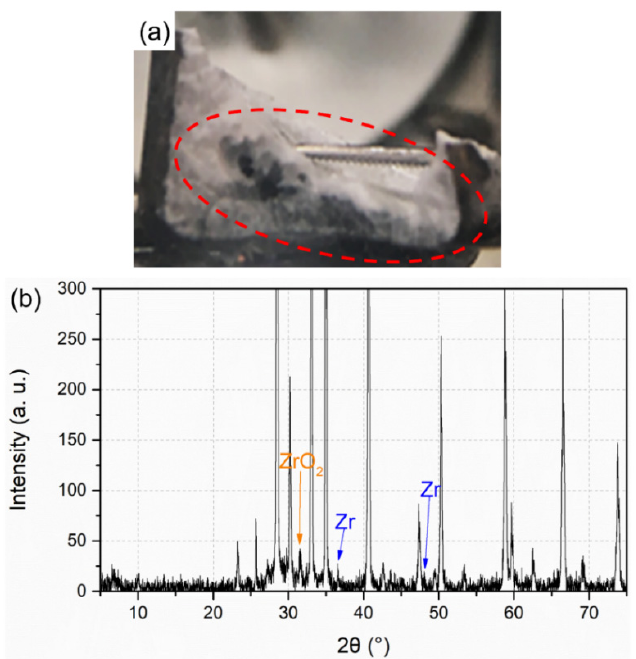
Figure 3. ( a ) Salt ingot obtained from the electrorefining cell in test 1; ( b ) XRD pattern of the black precipitate at the bottom of the salt ingot, represented as a red circle in Figure 3a.